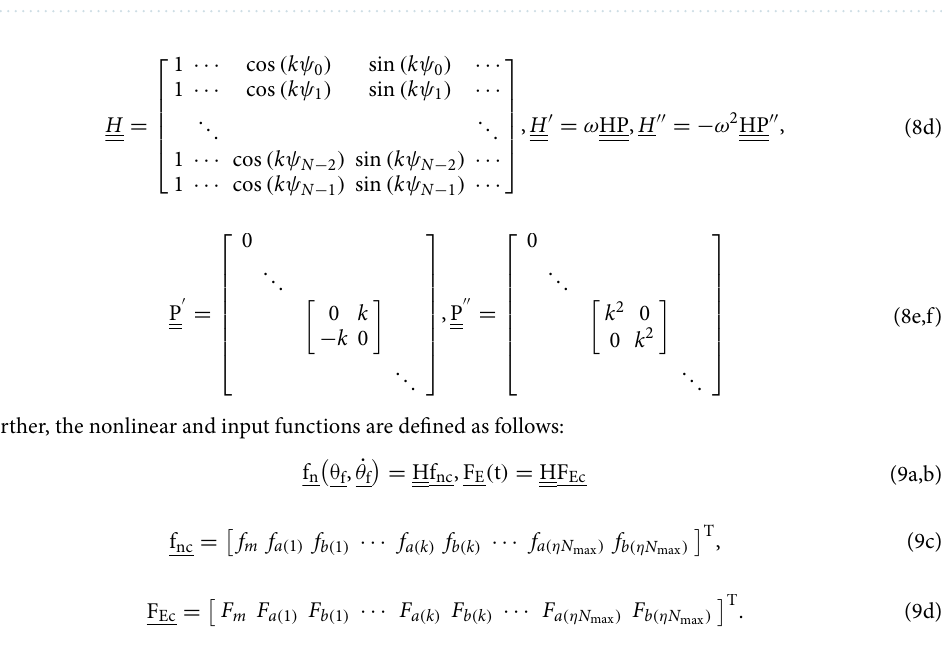
Figure 3. Nonlinear frequency response with RMS under frequency up-sweeping stability conditions: ( a ) comparison of the HBM with NS; ( b ) comparison of the HBM and NS at sub-harmonic resonance. Key: Blue Open circle, NS with frequency up-sweeping; Green plus, NS with frequency down-sweeping; Black line, HBM result; Red times, HBM result under the unstable condition 8